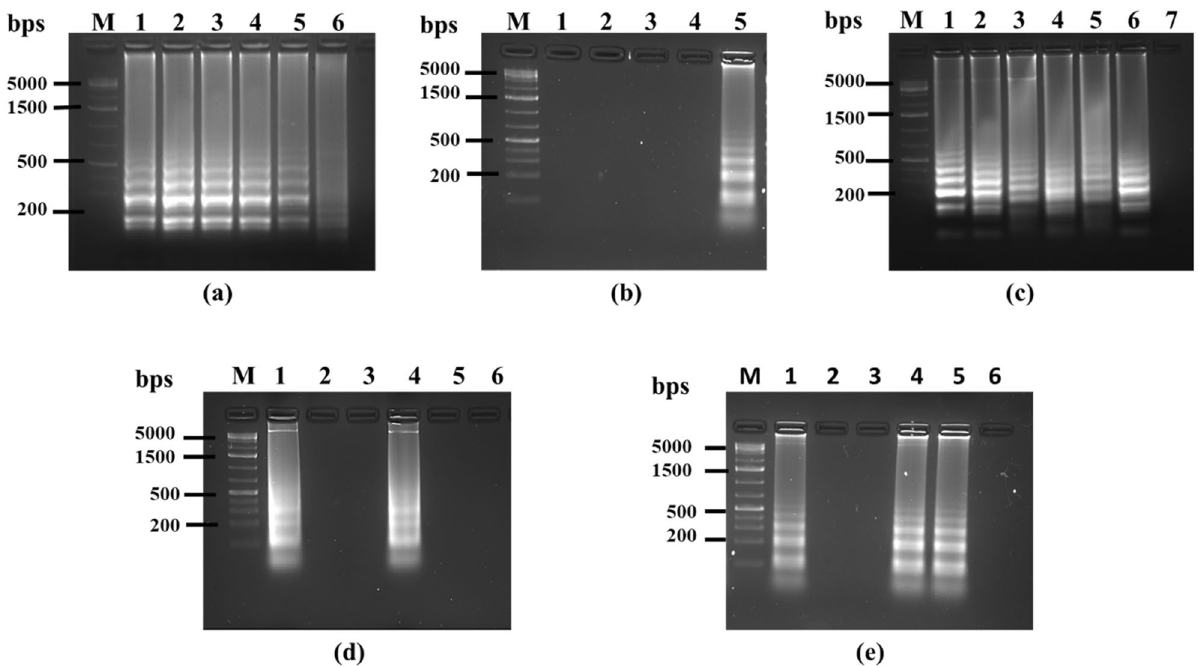
Figure 2. Gel electrophoresis analysis of amplification reactions under different LAMP parameters. ( a) Temperature optimization. Lanes: (M) Ladder, (1) 65 °C, (2) 66 °C, (3) 67 °C, (4) 68 °C, (5) 69 °C and (6) 70 °C ( b ) Reaction time optimization. Lanes: (1) 0 min, (2) 15 min, (3) 30 min, (4) 45 min and (5) 60 min, ( c ) Template concentration optimization. Lanes: (1) 1 ng, (2) 0.5 ng, (3) 0.1 ng, (4) 0.05 ng, (5) 0.01 ng, (6) 5 pg, (7) 1 pg, ( d ) Comparison of reaction heat source. Lanes 1–3: Heat block, Lanes 4–6: Water bath. (Lanes 1 & 4) ML DNA, (Lanes 2 & 5) MTB control, (Lanes 3 & 6) E.coli control, Lane M ladder, ( e ) Specificity of 16S